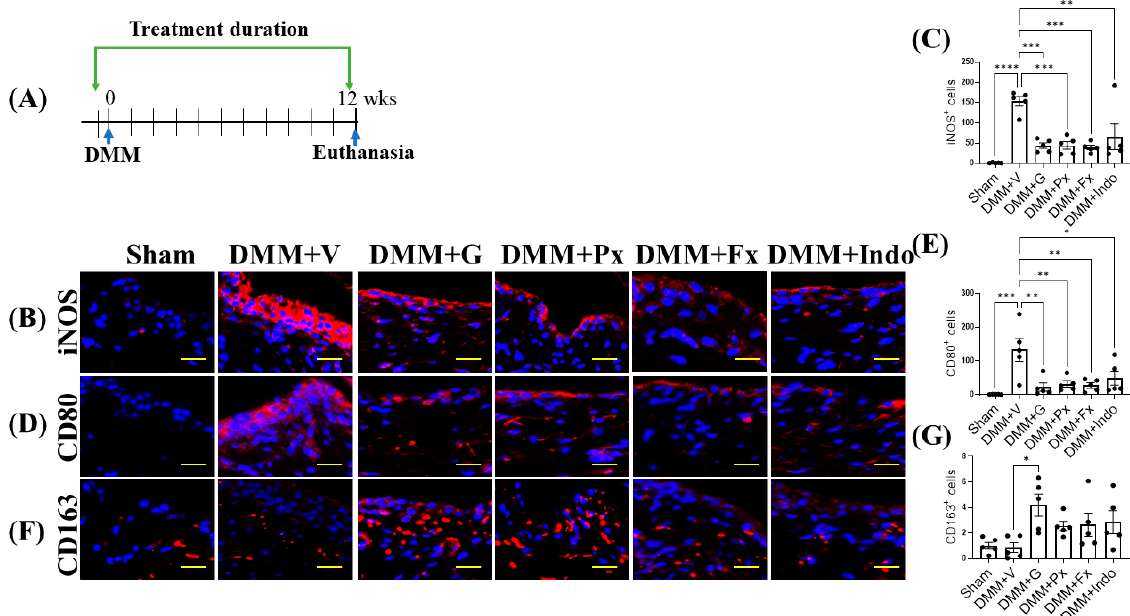
Figure 6. Early continuous G βγ -GRK2 inhibition switches synovial macrophage phenotype to M2 in late-stage PTOA. ( A ) Schematic representation of timeline of drug treatment after sham ( n = 5) or DMM surgeries. Two days before surgery, mice started receiving daily intraperitoneal injections of vehicle (V; n = 5), gallein (G; 10 mg/kg per day, n = 7), paroxetine (Px; 5 mg/kg per day, n = 5), fluoxetine (Fx; 5 mg/kg per day, n = 6), or indomethacin (Indo; 2.5 mg/kg per day, n = 7). All mice were euthanized 12 weeks after surgery. Green arrows denote the duration of drug treatment. Representative images of IF staining of (M1 markers) ( B ) iNOS, ( D ) CD80, and ( F ) CD163 (M2 marker) in the in the anterior femoral synovium of sham and DMM mouse knee sections 12 weeks after DMM or sham surgery. Target proteins are represented in red. DAPI (blue) stains nuclei; scale bar, 50 µ m. Quantification of the percentage of positive cells expressing ( C ) iNOS, ( E ) CD80, and ( G ) CD163. n = 5 per group; * p < 0.05, ** p < 0.01, *** p < 0.001, and **** p < 0.0001 vs. DMM + V group using one-way ANOVA; values are expressed as means ± SEM.